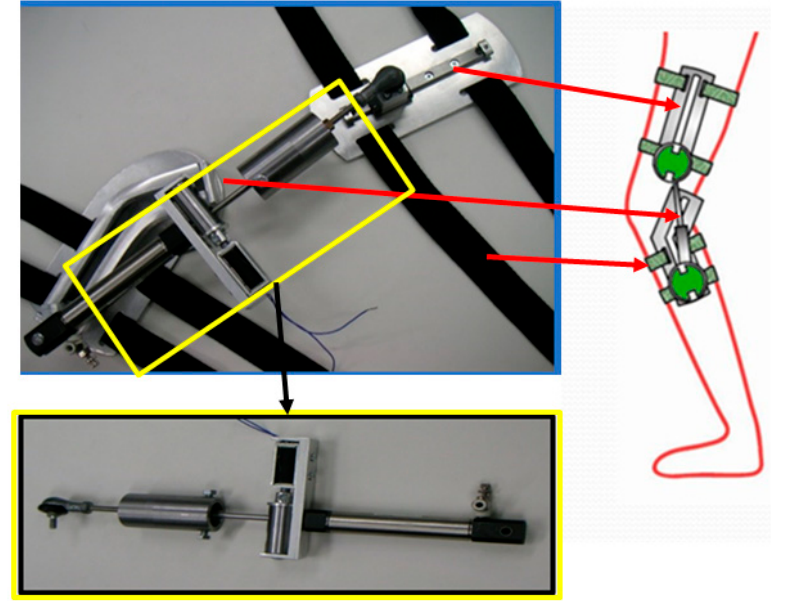
Figure 11. Schematic of cylinder slide system.